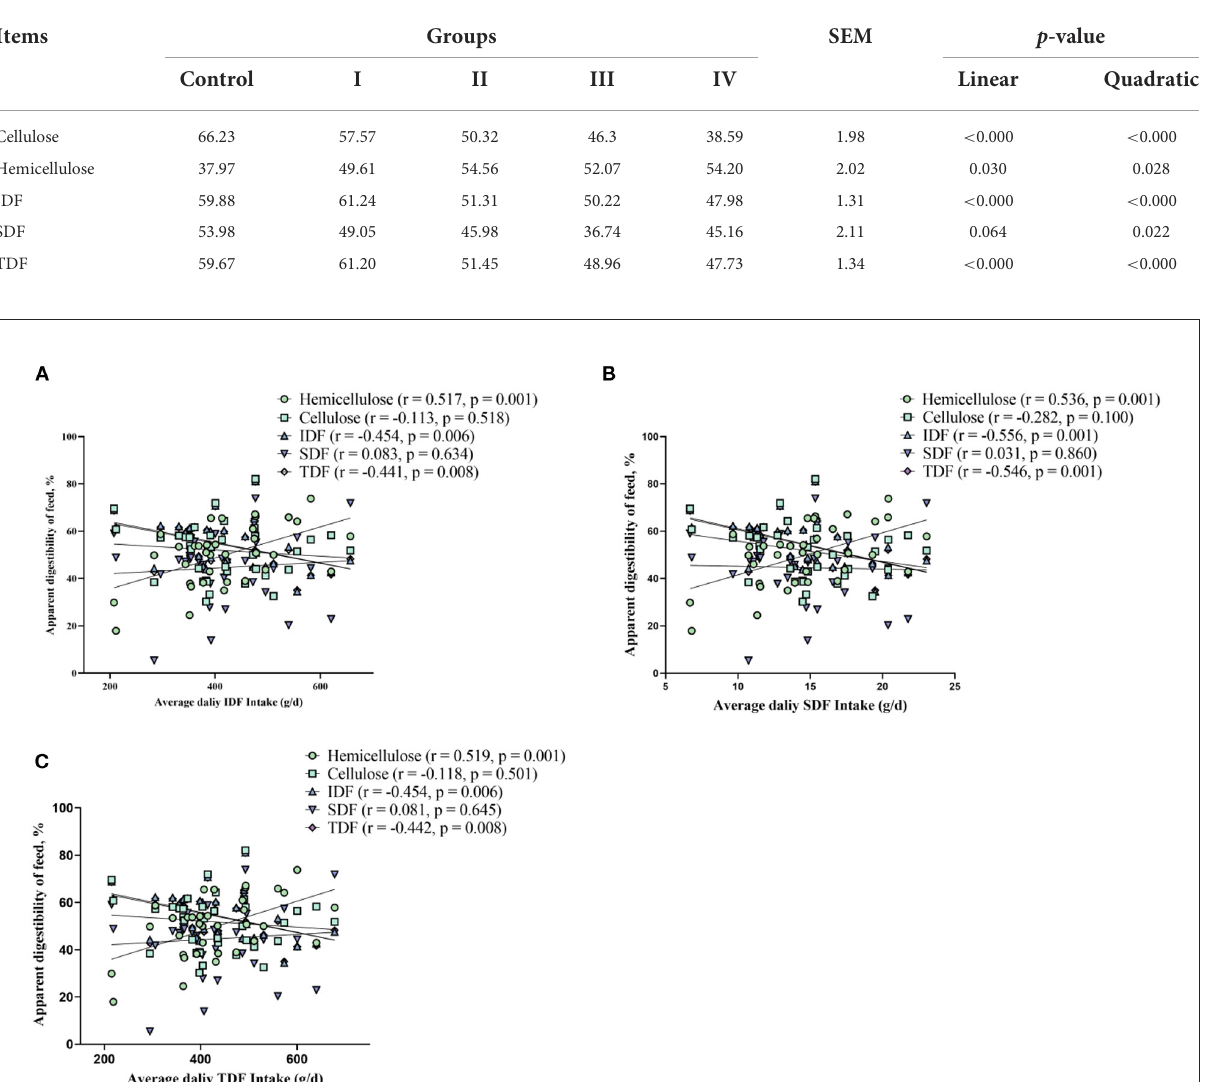
TABLE 2 The effects of short-term feeding of DFRB-containing diets on apparent total tract digestibility of fiber in finishing pigs.